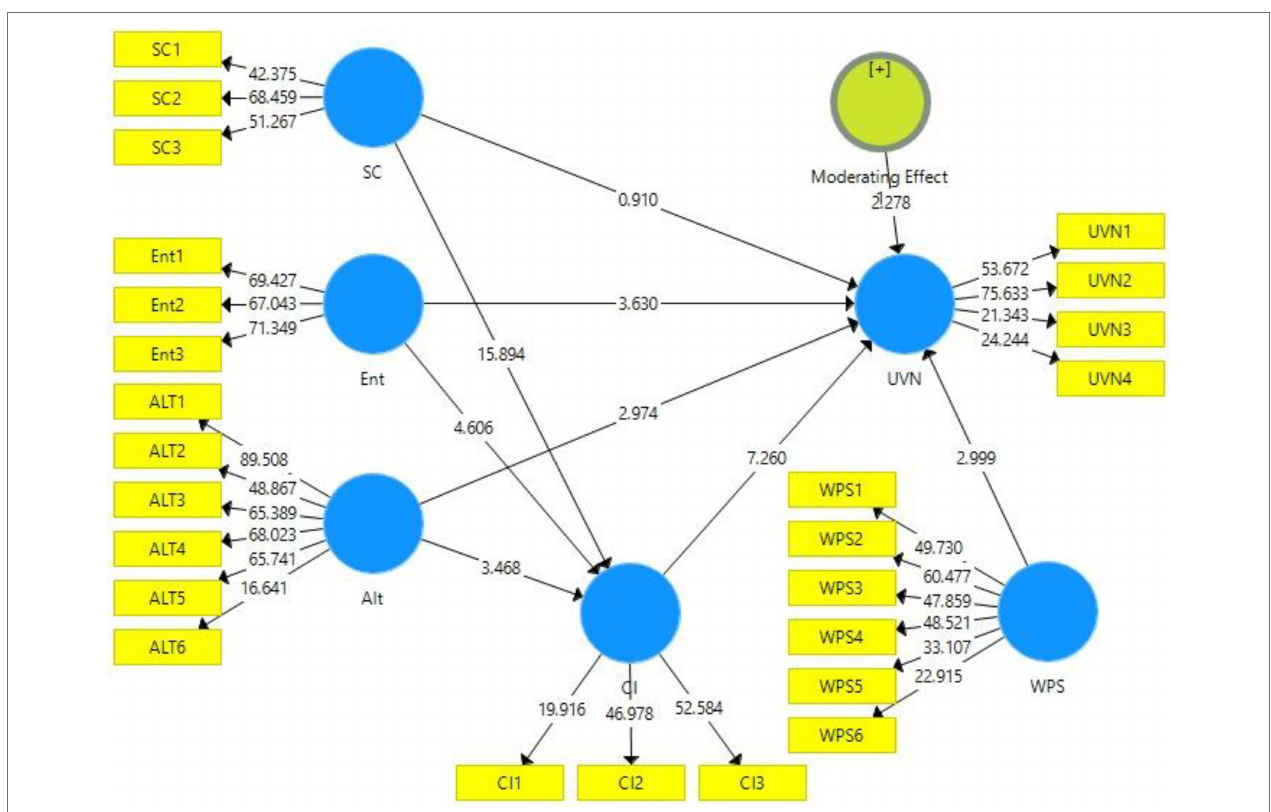
FIGURE 5 | Structural model bootstrapping with Moderation. SC, Social Consciousness of Employees; Ent, Entertainment; Alt, Altruism; UVN, Unverified News Sharing; CI, Corporate Image; and WPS, Workplace Stress.